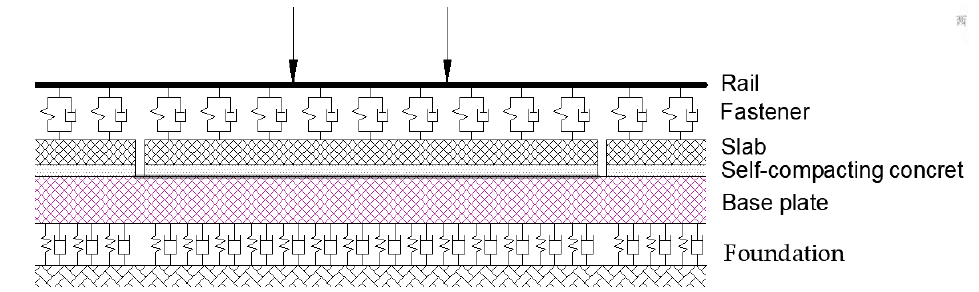
Figure 10. Load loading method.